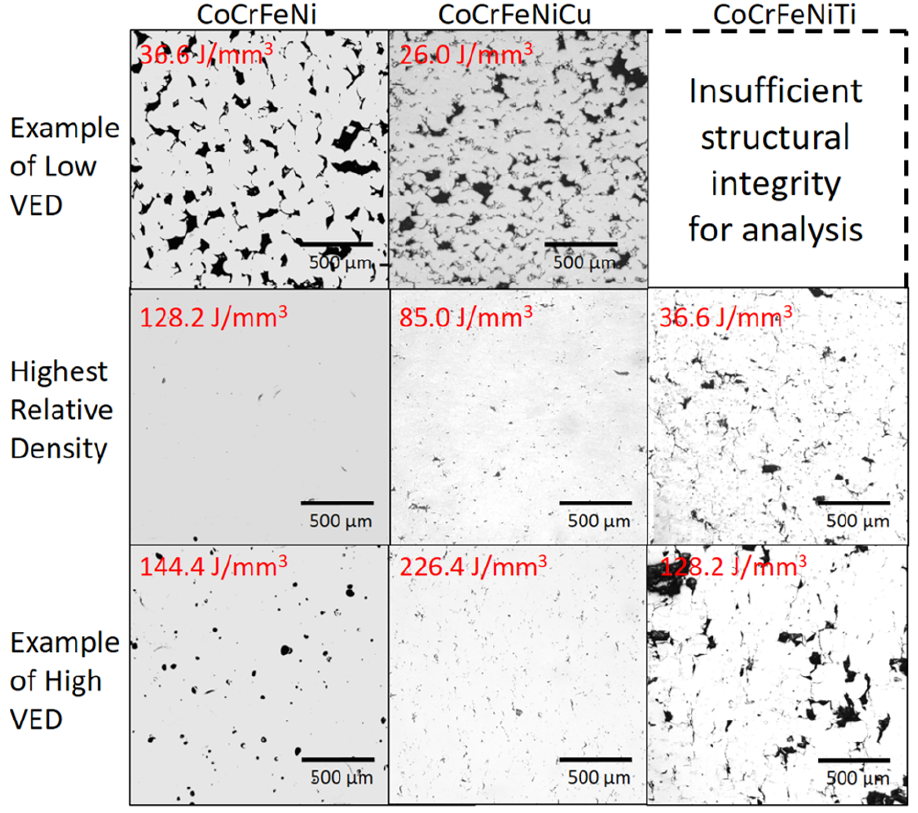
Figure 2. Optical Microscopy images of highest relative density sample, as well as examples of samples with low and high VED, for each alloy resulting from the DOE. VED values for each sample are shown in red. All scale bars are 500 µ m. The low VED sample for the CoCrFeNiTi alloy had insufficient structural integrity for sectioning and subsequent